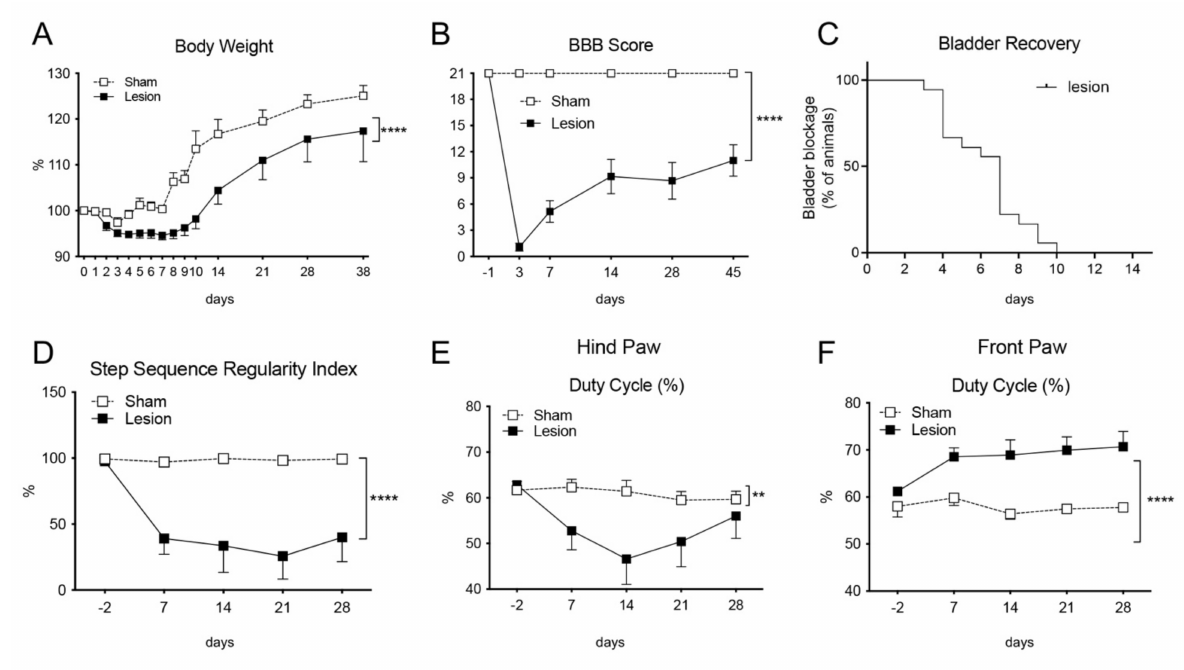
Figure 1. Animal monitoring of body weight ( A ), BBB scale of locomotion ( B ), spontaneous bladder function recovery, defined as percentage of animals showing bladder blockage during the observational time ( C ), step sequence regularity index ( D ) and duty cycle of the hind- ( E ) and front paws ( F ). Results are presented as mean ± SEM; statistical analysis: two-way ANOVA, ** p < 0.01; **** p <